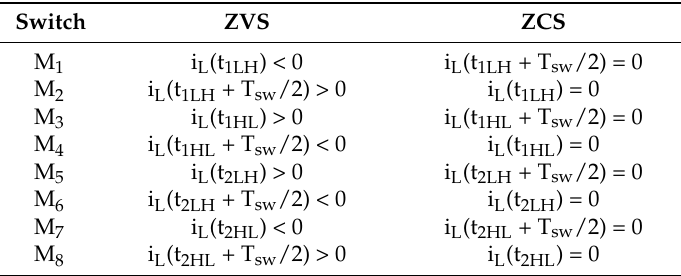
Table 3. Soft switching conditions for each switch.